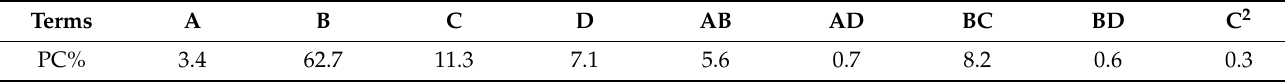
Table 5. PC% for current model terms.